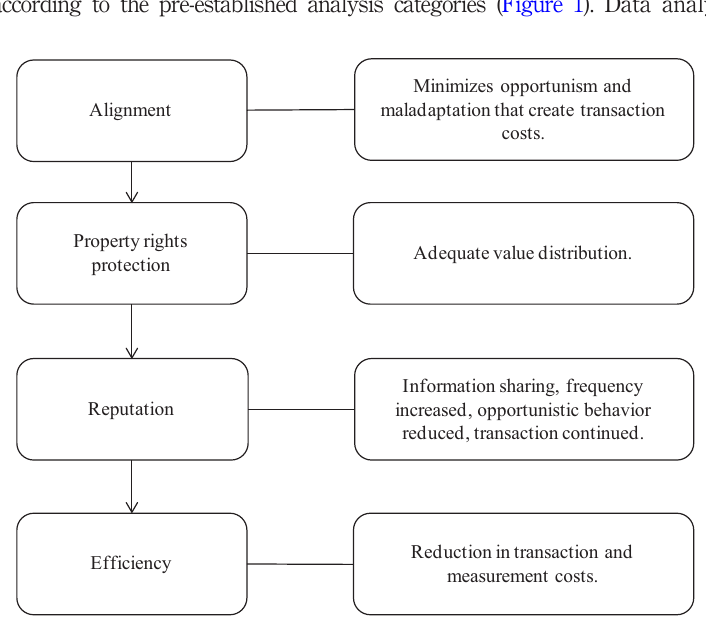
Propertyrights protection